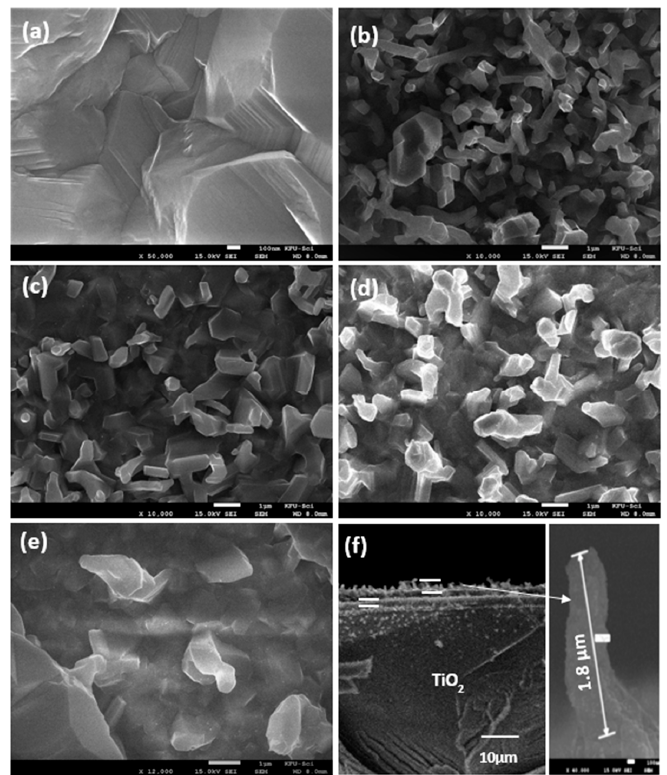
Figure 1. Scanning electron microscopy measurement of: ( a ) Ag 0 / TiO 2 , ( b ) Ag 5 / TiO 2 , ( c ) Ag 10 / TiO 2 , ( d ) Ag 20 / TiO 2 , ( e ) Ag 40 / TiO 2 , and ( f ) the cross-sectional image for the prepared sample of Ag 10 / TiO 2 .